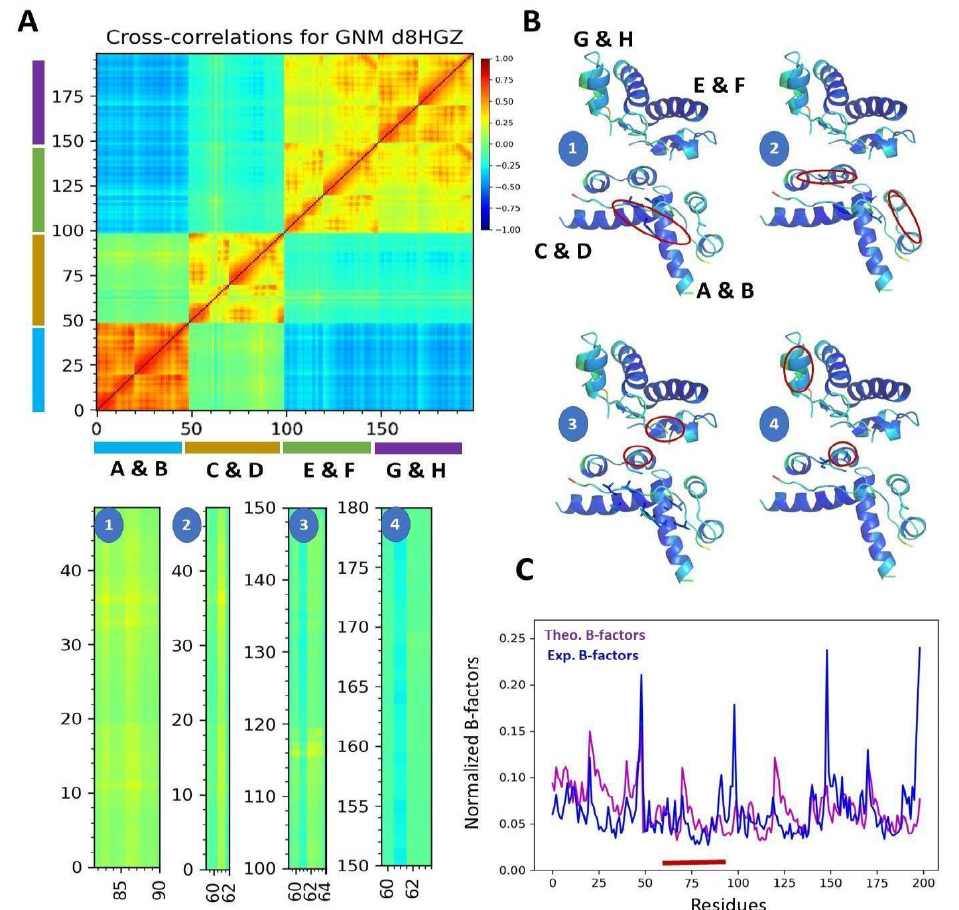
Figure 4. Gaussian network model (GNM) analysis results for 8HGZ structure. ( A ) Crosscorrelation heat-map from overall GNM modes for our structure and ~25% correlated critical residues in the AB-CD dimer. The residue pairs that move in the same direction are colored in red regions (Cijorient > 0); the residue pairs moving in opposite directions are colored in blue regions (Cijorient < 0); uncorrelated pairs are colored in green (Cijorient = 0.0; color-code bar on the right scale). ( B ) The cartoon representation of our structure are ncolored in B-factor. Critical residues corresponding to the heat map are numbered and emphasized in red circles. ( C ) Normalized B-factors of the structure are colored in blue, and theoretical B-factors calculated by GNM are colored in magenta. Critical residues corresponding to the heat map are emphasized in red lines.